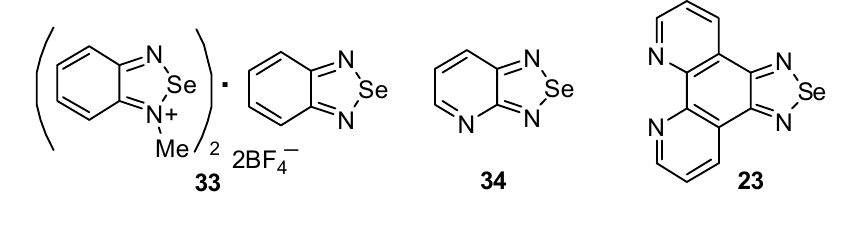
Figure 3. Selenadiazole derivatives 23 , 33 and 34